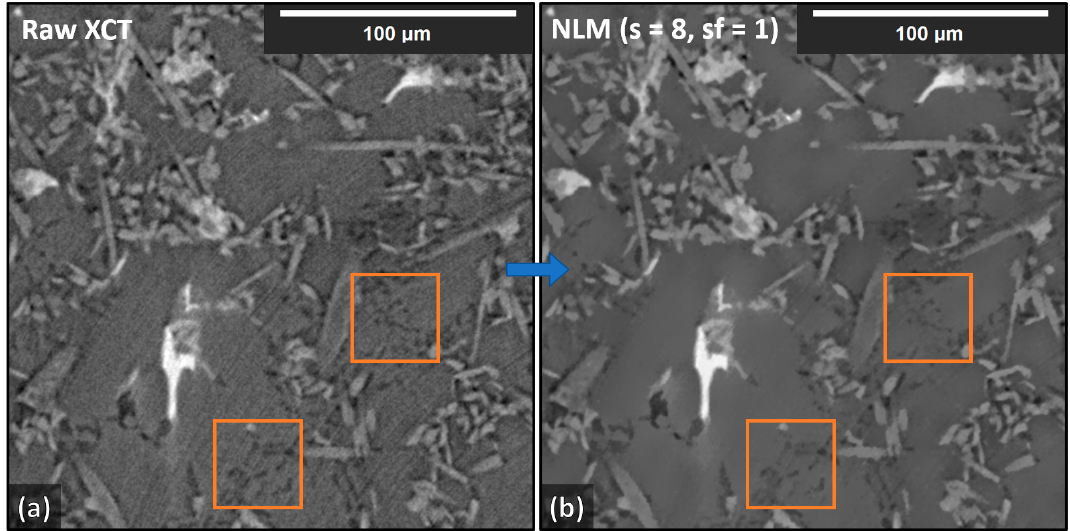
Figure 7. AlSi12CuMgNi MMC XCT reconstruction cross-sections (512 × 512, XY-plane view) before (unconditioned) and after (conditioned) the application of an NLM Filter with s = 8 and sf = 1. The squares show regions where some structural loss (due to filtering) can be observed. ( a ) without filtering, ( b ) with NLM filtering.